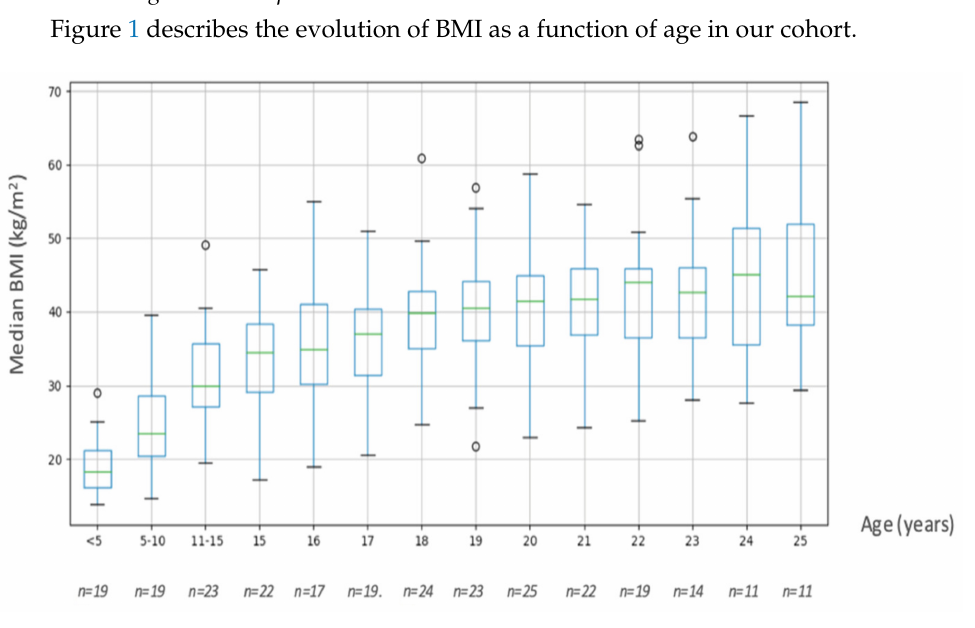
Figure 1. Change in BMI as a function of age in the whole population. BMI was collected between 0 to 5 years, 5 to 10 years, 10 to 15 years, and thereafter from 16 to 20 years. Most patients had severe obesity. From the age of 15, the median BMI was consistently over 30 kg/m 2 . There was a huge increase in the median BMI between the ages of 15 and 20 years, with a gain of about 6 points. BMI at 15 and 20 years was known for 17 out of 39 patients and the median BMI gain was 6.6 [2.1; 11] for these patients between 15 and 20